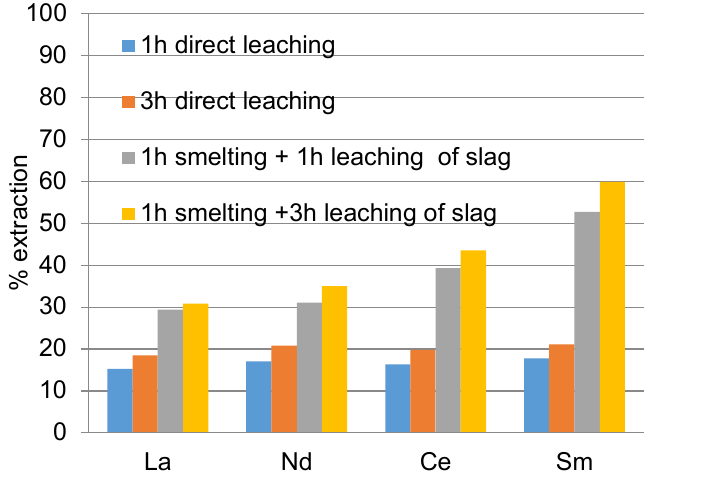
Figure 5 – Percentage of rare earth recovery by direct leaching in comparison to the two step strategy: smelting and leaching of